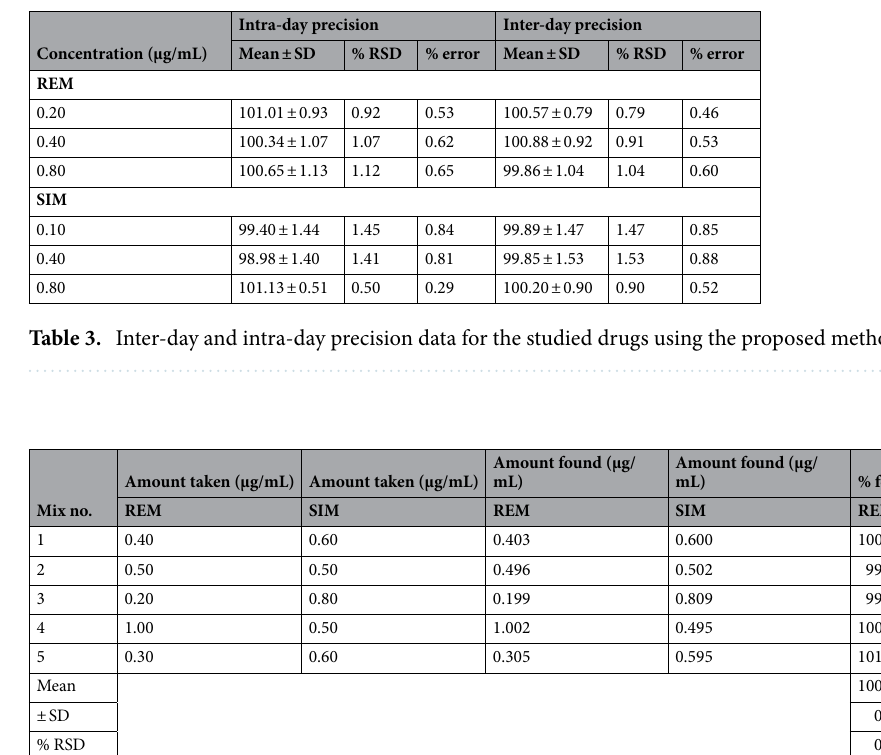
Table 4. Assay results for the determination of REM and SIM in synthetic mixtures using the proposed method. a Mean of three determinations.